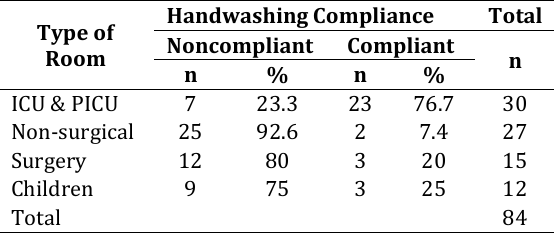
Table 3. Percenta ge Distribution of Respondents’ Handwashing by Type of